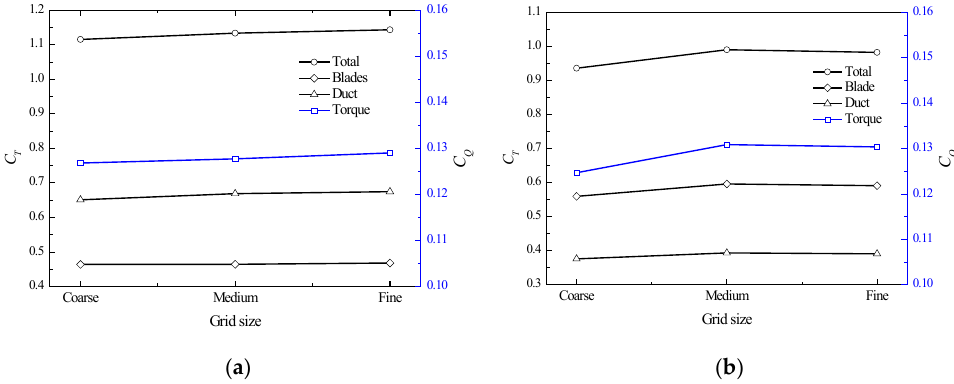
Figure 10. Coefficients calculated by different grid densities; ducted fan studied in this paper: ( a ) hovering out of ground effect; ( b ) hovering in ground effect. ( a ) hovering out of ground effect; ( b ) hovering in ground